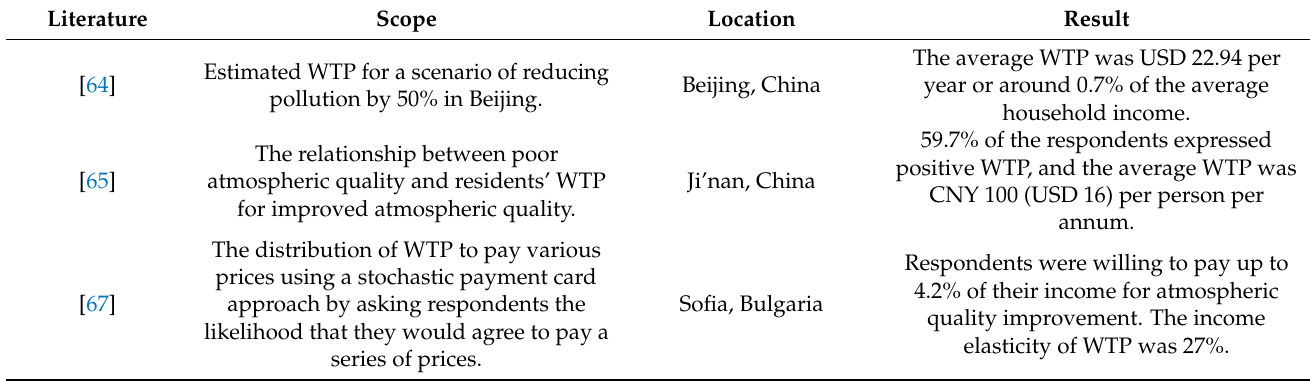
Table 2. Empirical studies on economic valuation of atmospheric quality improvement using the contingent valua- tion